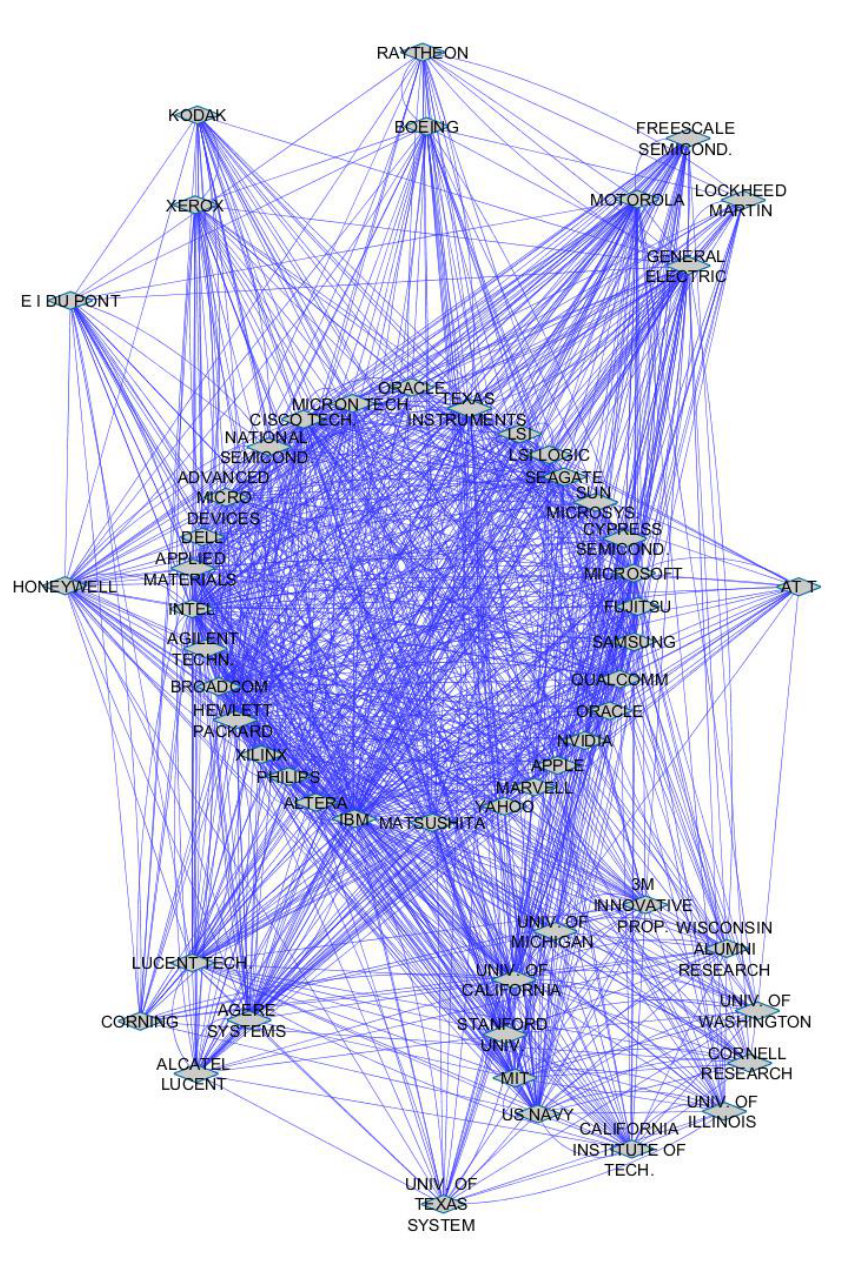
Fig. 5. The core of the US inventor mobility network with 58 organizations and 1112